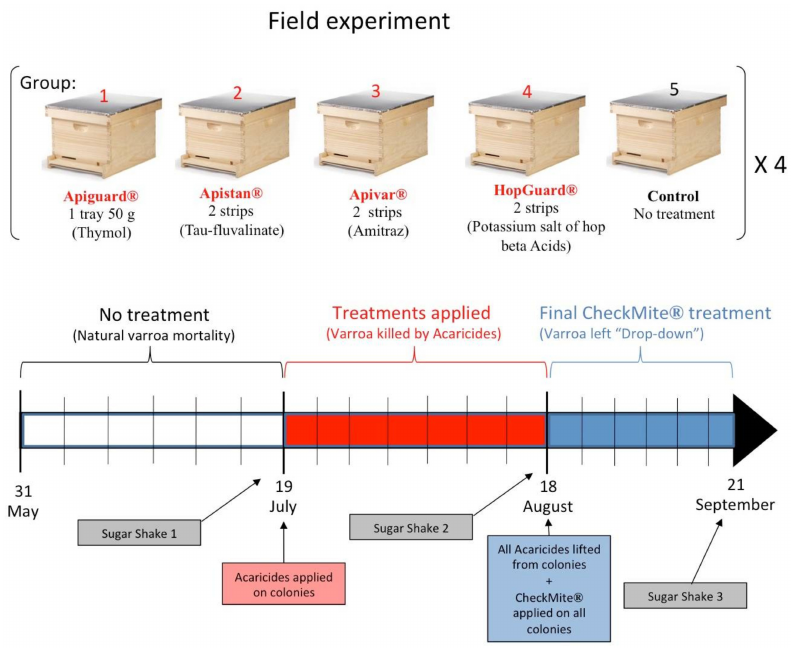
Figure 2. Field experimental design showing the acaricidal products that were tested, amounts of product used in each honey bee colony, and the timeline detailing the products and their application